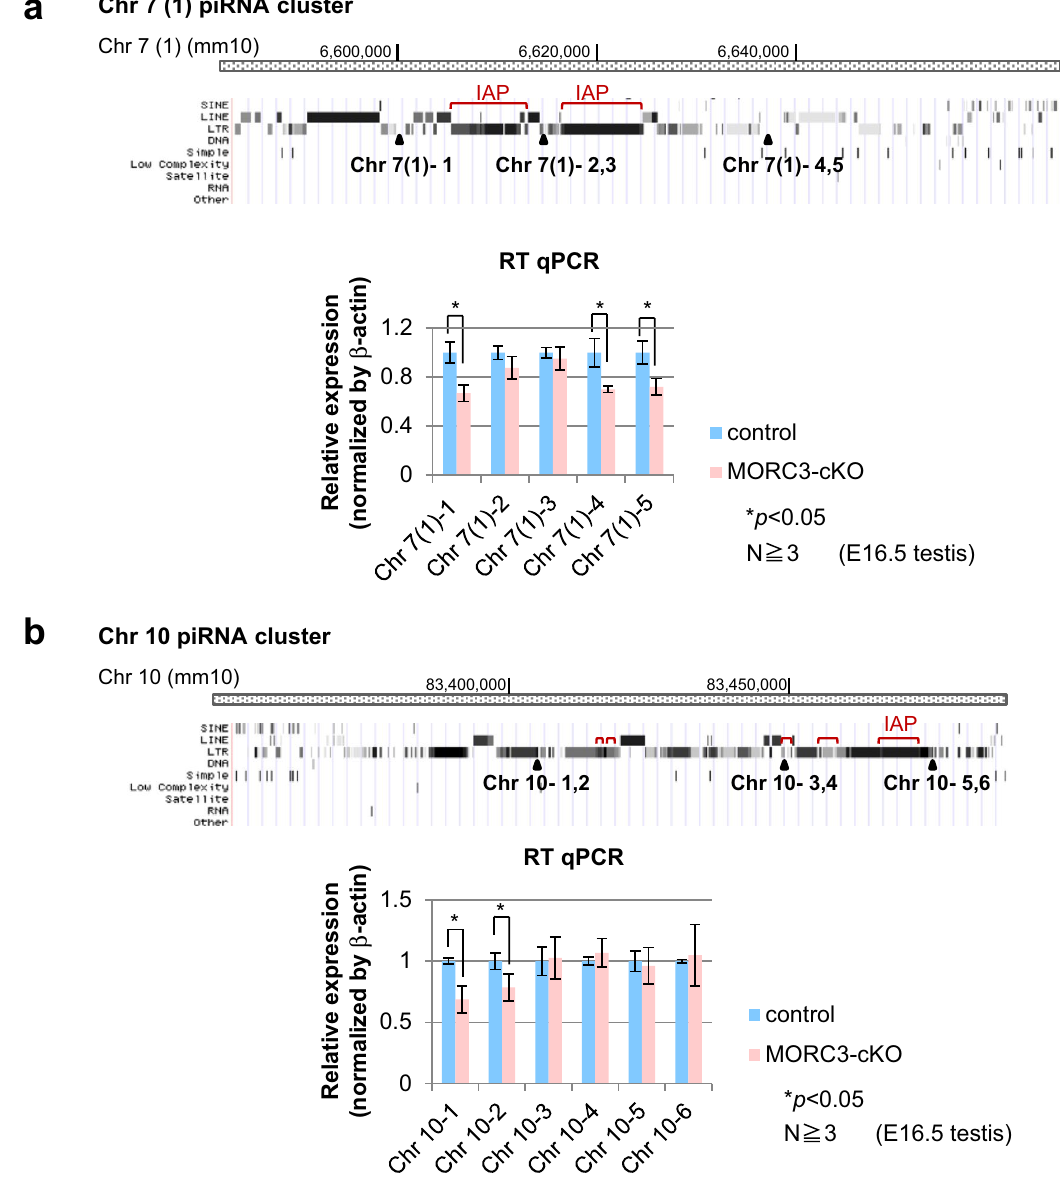
Figure 6. Expression of piRNA precursors from representative embryonic piRNA clusters. ( a and b ) Structure of the piRNA clusters (Chr 7 (1) and Chr 10) and positions of individual primer sets. The regions of the IAP element sequence in each cluster are described with red bars (from piRBase in UCSC Genome Browser mm10) (upper). Quantitative RT-PCR for the expression analysis of piRNA precursors transcribed from embryonic piRNA clusters using E16.5 wild type and MORC3-cKO embryonic testes (bottom). Data is normalized by β-actin and is shown as means and SD (Error bar) from more than triplicate PCR reactions. Significant differences ( * p < 0.05 by the t test) between wild type and MORC3-cKO data using primer sets for the Chr 7 (1)- 1, 4, and 5 positions ( a ) and Chr 10–1 and 2 positions ( b ) are shown. ( c ) Schematic diagram of de novo DNA methylation pathway mediated piRNAs biogenesis involved with